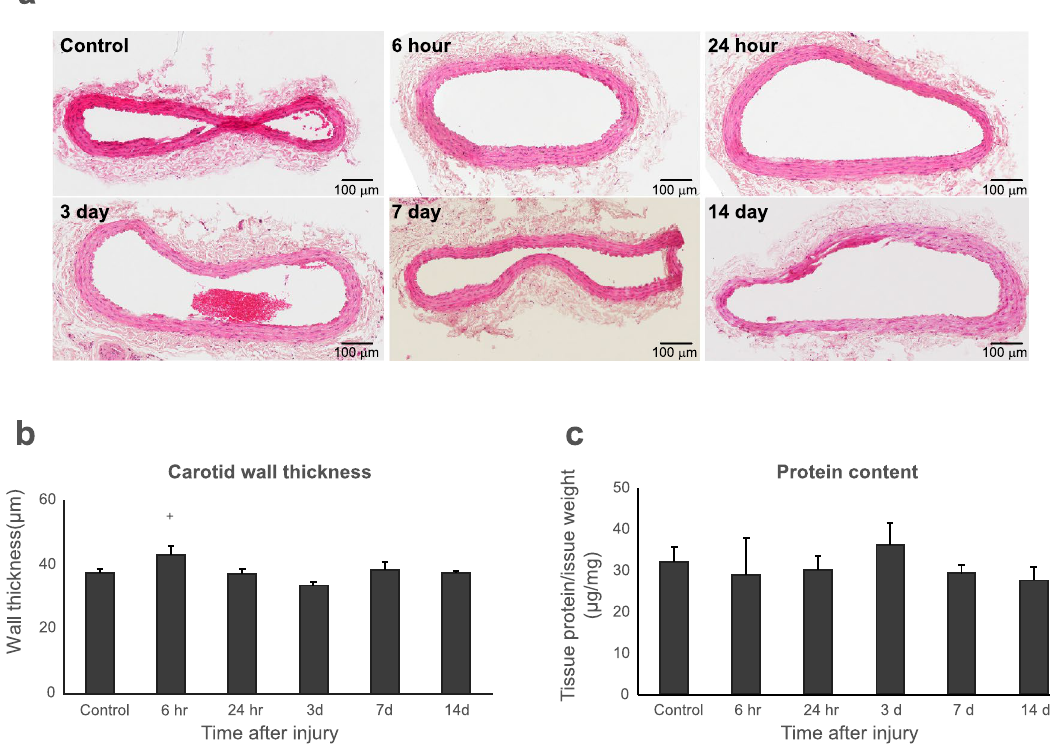
Figure 2. ( a ) Histology images of rat carotid ring tissue; ( b ) Statistical analysis of carotid wall thickness in burn rats; ( c ) Carotid protein content in burn rats. +, p < 0.05, 6 h (hr) versus 3 days ( d ). One-way ANOVA with Bonferroni t-tests was applied. Data were presented as mean ±